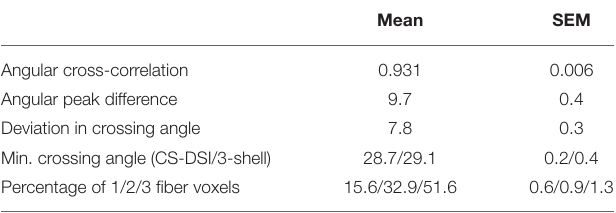
TABLE 3 | Quantitative analysis of the orientational information obtained from CS-DSI and 3-shell HARDI acquisitions: Group mean and standard error are reported for the angular cross correlation of both schemes, the angular deviation in the estimated fiber directions and in the crossing angle in multi-fiber voxels, the minimum crossing angle resolved by each scheme and the percentages of 1/2/3 fiber voxels within the WM